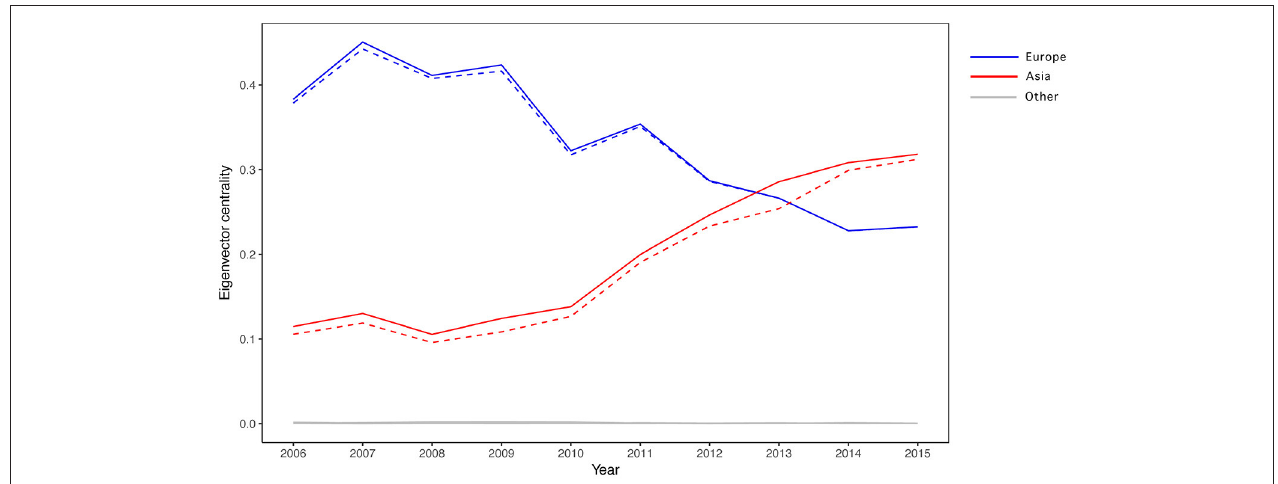
FIGURE 3 | Total eigenvector centrality of regions between 2006 and 2015. Solid lines denote values based on all trade and hashed lines represent trade without re-exports